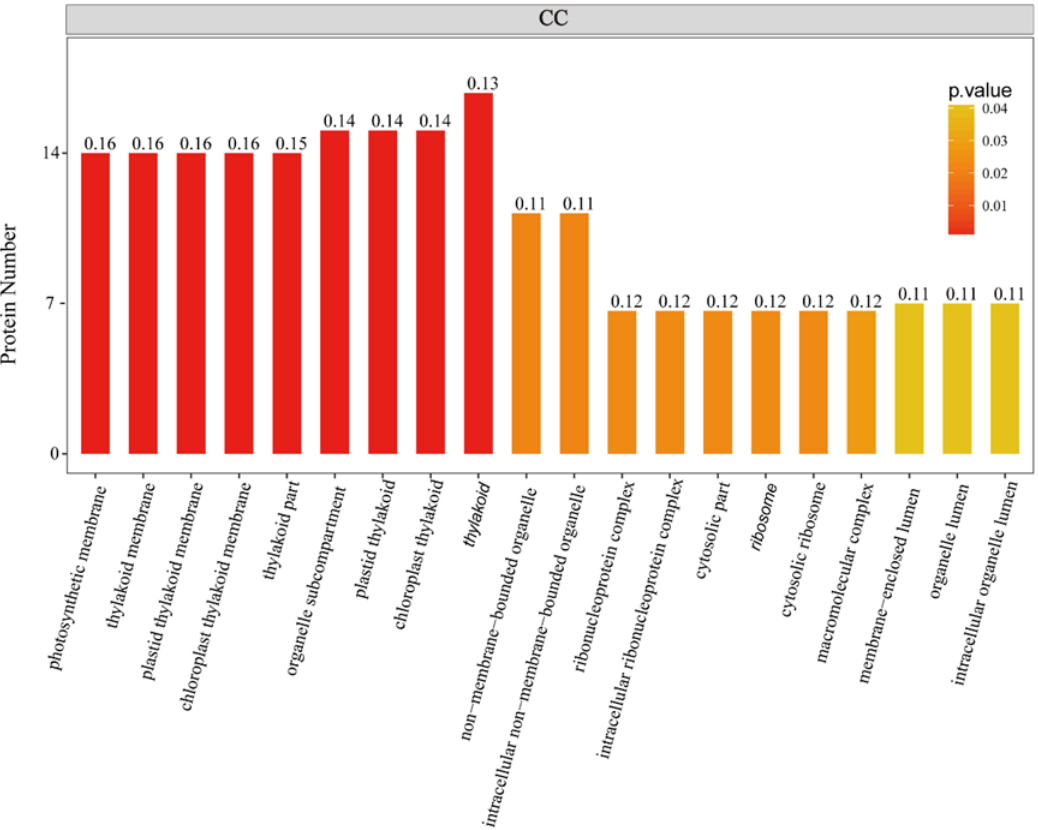
Figure 4. GO enrichment analysis of STO-dependent UV-B-induced proteins. The color gradient indicates the P value. The smaller P value indicates that the color is closer to red, the higher the level of GO enrichment. The number on the bar graph indicates the rich factor (rich factor <= 1), referring to the percentage of differential proteins that are involved in this GO term.